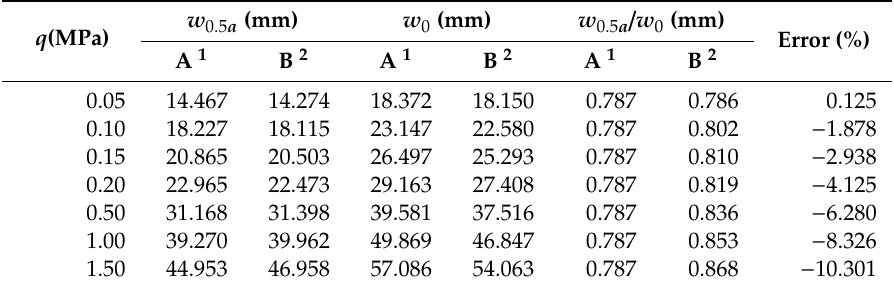
Table 1. The deflection of the thin film when q is equal to di ff erent